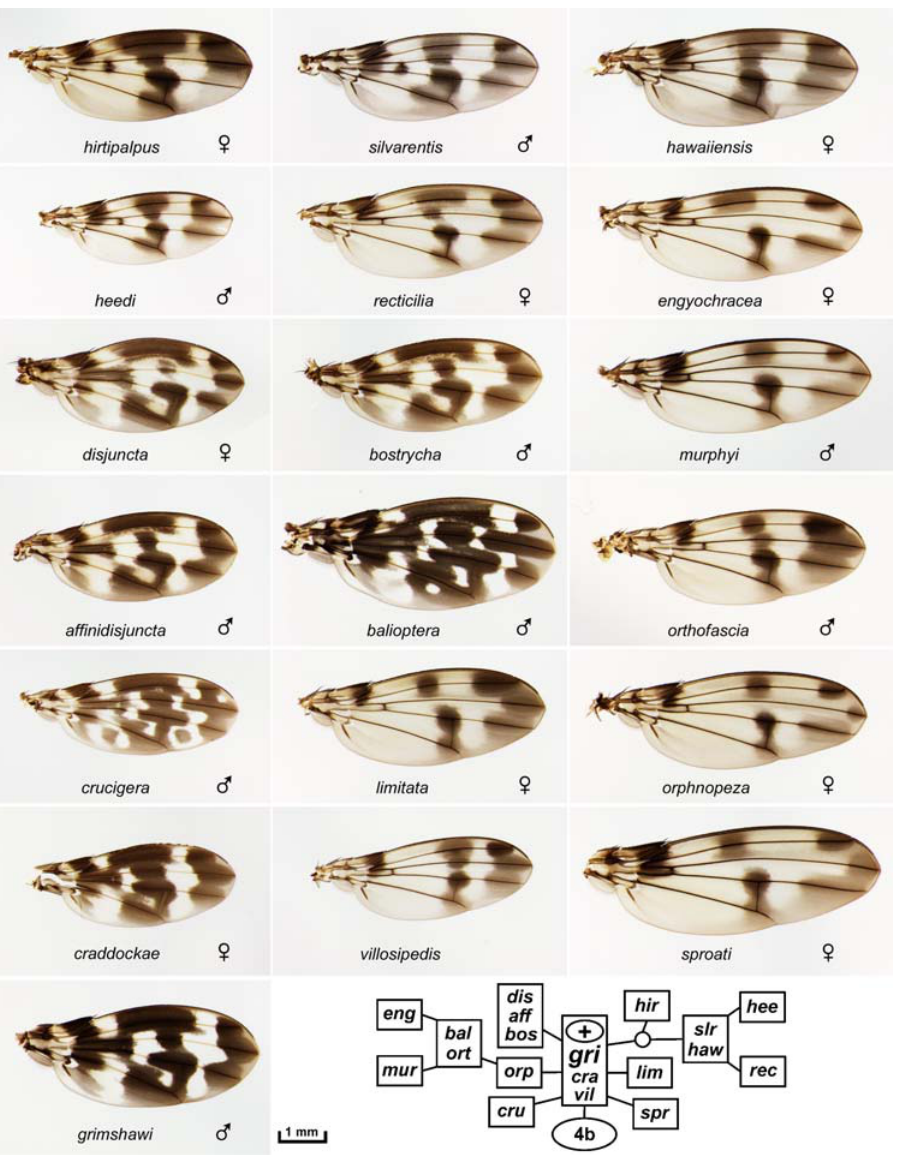
Figure 5. The grimshawi/4b + subgroup of picture wing species: D. affinidisjuncta, balioptera, bostrycha, craddockae, crucigera, disjuncta, engyochracea, grimshawi, hawaiiensis, heedi, hirtipalpus, limitata, murphyi, orphnopeza, orthofascia, recticilia, silvarentis, sproati , and villosipedis . Inset, chromosome inversion-based lineage for the species shown (see text).